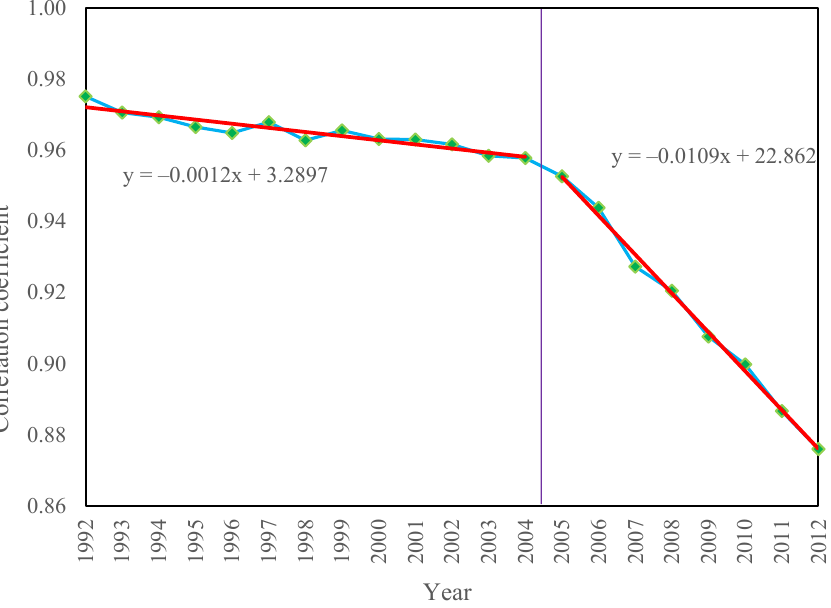
Figure 2. Correlation coefficients over time. Note: Correlation coefficients were calculated by 77 countries every year. Table 3. Correlation coe ffi cients of every